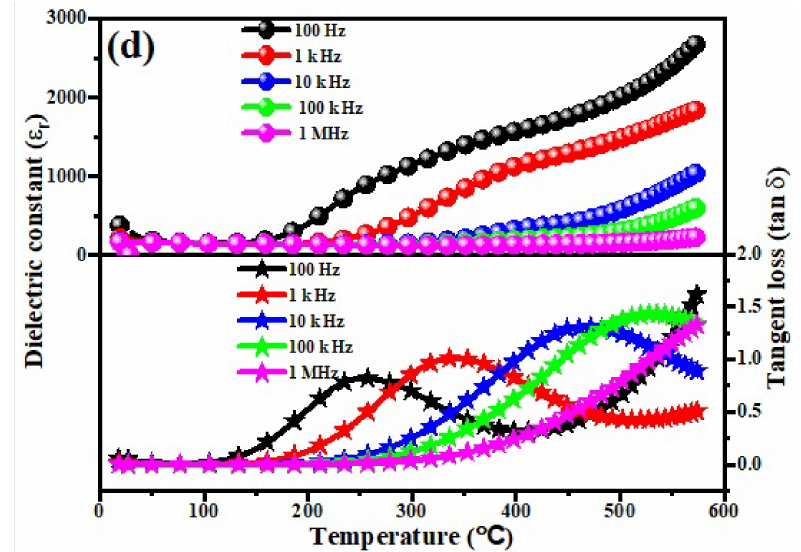
Figure 7. Variation of ε r and tan δ with temperature for the (Sr 1 − x Ca x ) 5 Ti 4 O 13 , 0.0 ≤ x ≤ 0.06 sintered